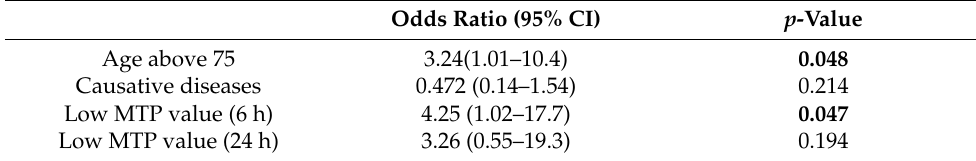
CI: confidence interval. Bold: p -values indicate